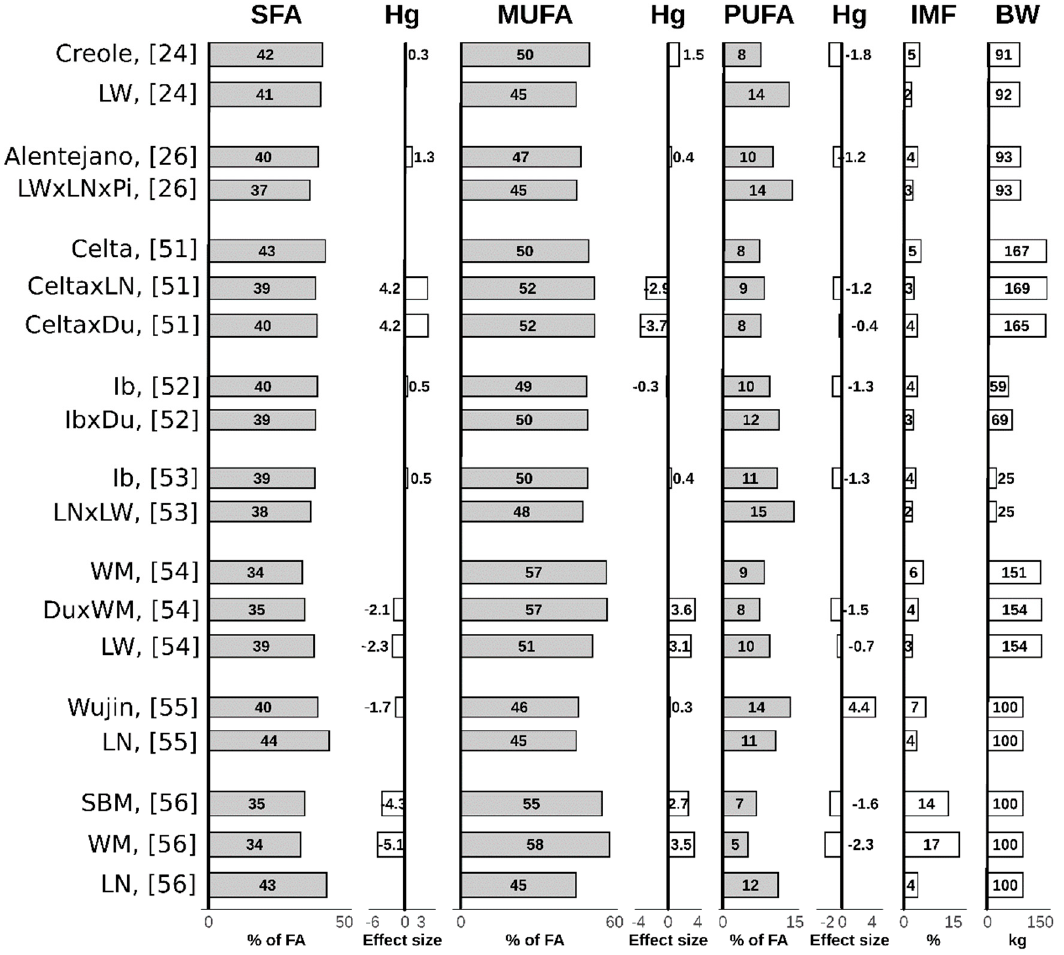
Figure 2. Fatty acids composition of intramuscular fat in longissimus dorsi muscle at given body weights of local vs. modern pig breeds or cross-breeds and within a study effect size (Hedges’ g) [27]. Studies differ with respect to experimental conditions (including BW and IMF) and should be interpreted accordingly. The effect size (Hedges’ g) [27] is considered to be medium if it is above 0.5 or below − 0.5 and large if it is above 0.8 or below − 0.8. SFA = saturated fatty acids; MUFA = monounsaturated fatty acids; PUFA = polyunsaturated fatty acids; Hg = Hedges’g; IMF = intramuscular fat; BW = body weight; LW = Large White; LN = Landrace; Pi = Piétrain; Ib = Iberian; Du = Duroc; WM = White Mangalitsa; SBM = Swallow bellied Mangalitsa.